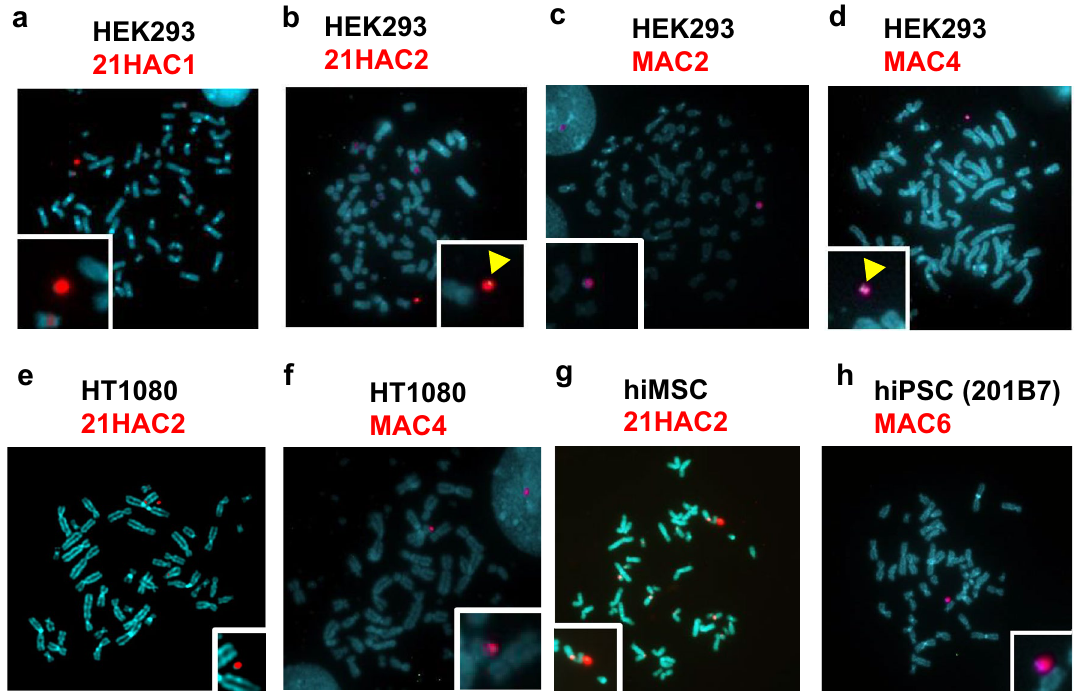
Figure 2. Representative images of FISH analyses of HEK293 cells, HT1080 cells, hiMSCs, and iPSCs that contained each HAC/MAC. ( a ) HEK293 cells that contained 21HAC1. Red: alpha satellite probe (p11-4) staining the centromere of Chr.13, 21, 21HAC1. ( b ) HEK293 cells that contained 21HAC2. Red: alpha satellite probe (p11-4) staining the centromere of Chr.13, 21 and 21HAC2; green: pCX-EGFP. ( c ) HEK293 cells that contained MAC2. Red: mouse cot-1 staining MAC2. ( d ) HEK293 cells that contained MAC4. Red: mouse cot-1 staining MAC4. ( e ) HT1080 cells that contained 21HAC2. Red: alpha satellite probe (p11-4) staining the centromere of Chr.13, 21, 21HAC1. ( f ) HT1080 cells that contained MAC4. Red: mouse cot-1 staining MAC4. ( g ) hiMSCs that contained 21HAC2. Red: alpha satellite probe (p11-4) staining the centromere of Chr.13, 21 and 21HAC2. ( h ) hiPSCs (201B7) that contained MAC6. Red; mouse cot-1 staining MAC6. Inset: enlarged images of each HAC or